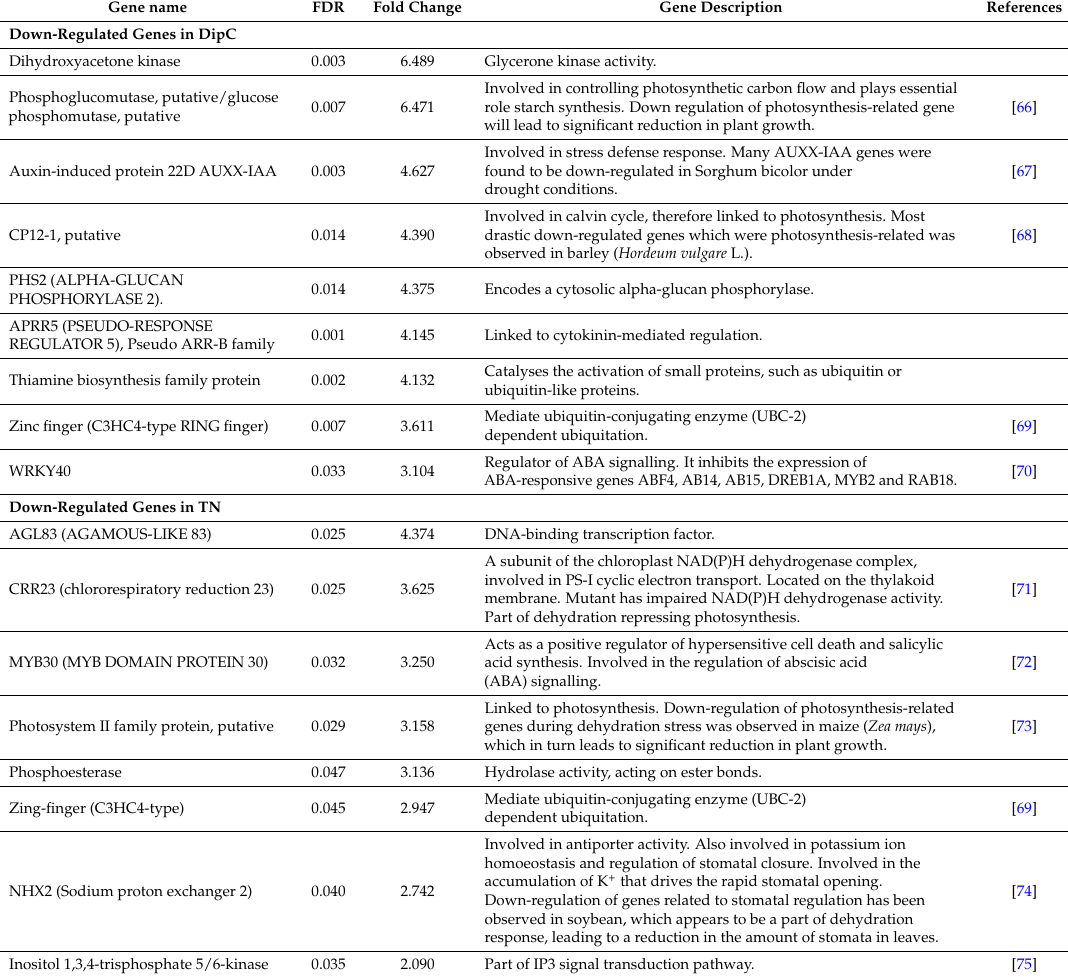
Table 4. Top downregulated genes in DipC and TN.